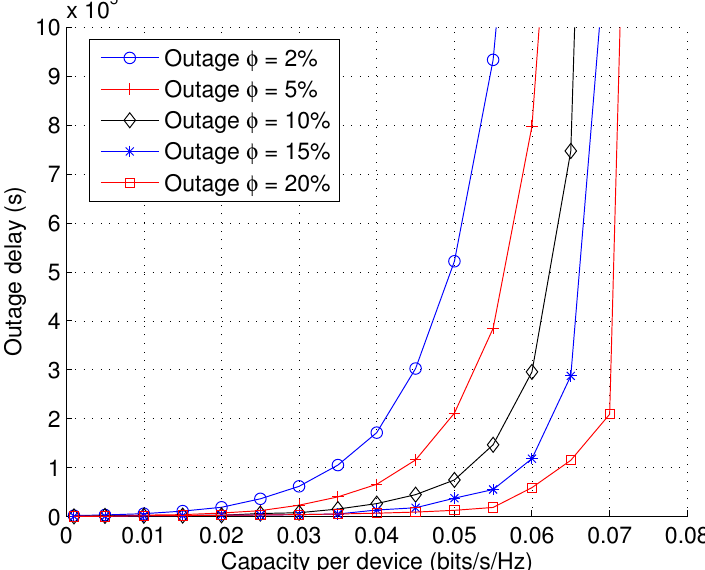
Figure 13. Outage delay D ( φ ) as a function of capacity per device C with varying outage threshold φ ( P I = ∞ , P II = ∞ , λ b = 10 − 5 , arbitrary λ u , L = 1, v =